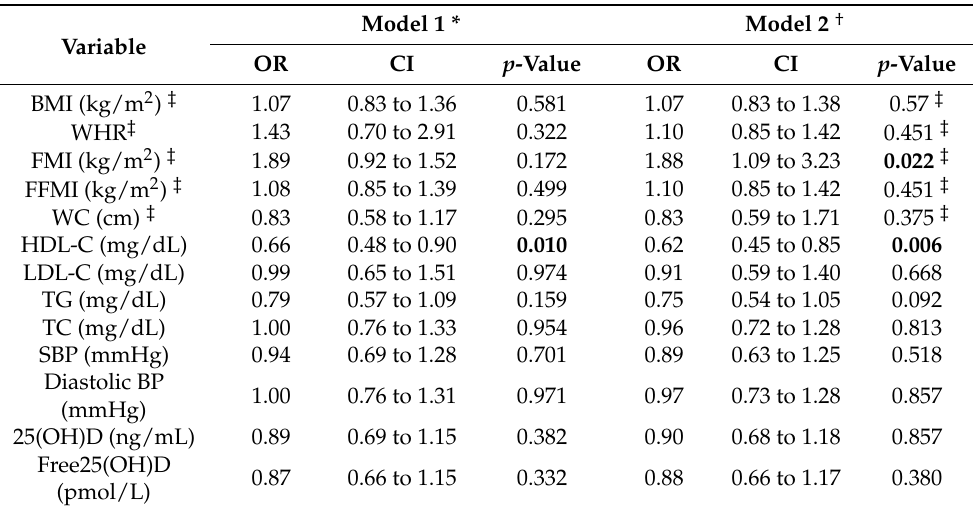
Table 4. Correlations between anthropometric measurements, lipid profile, and blood pressure with